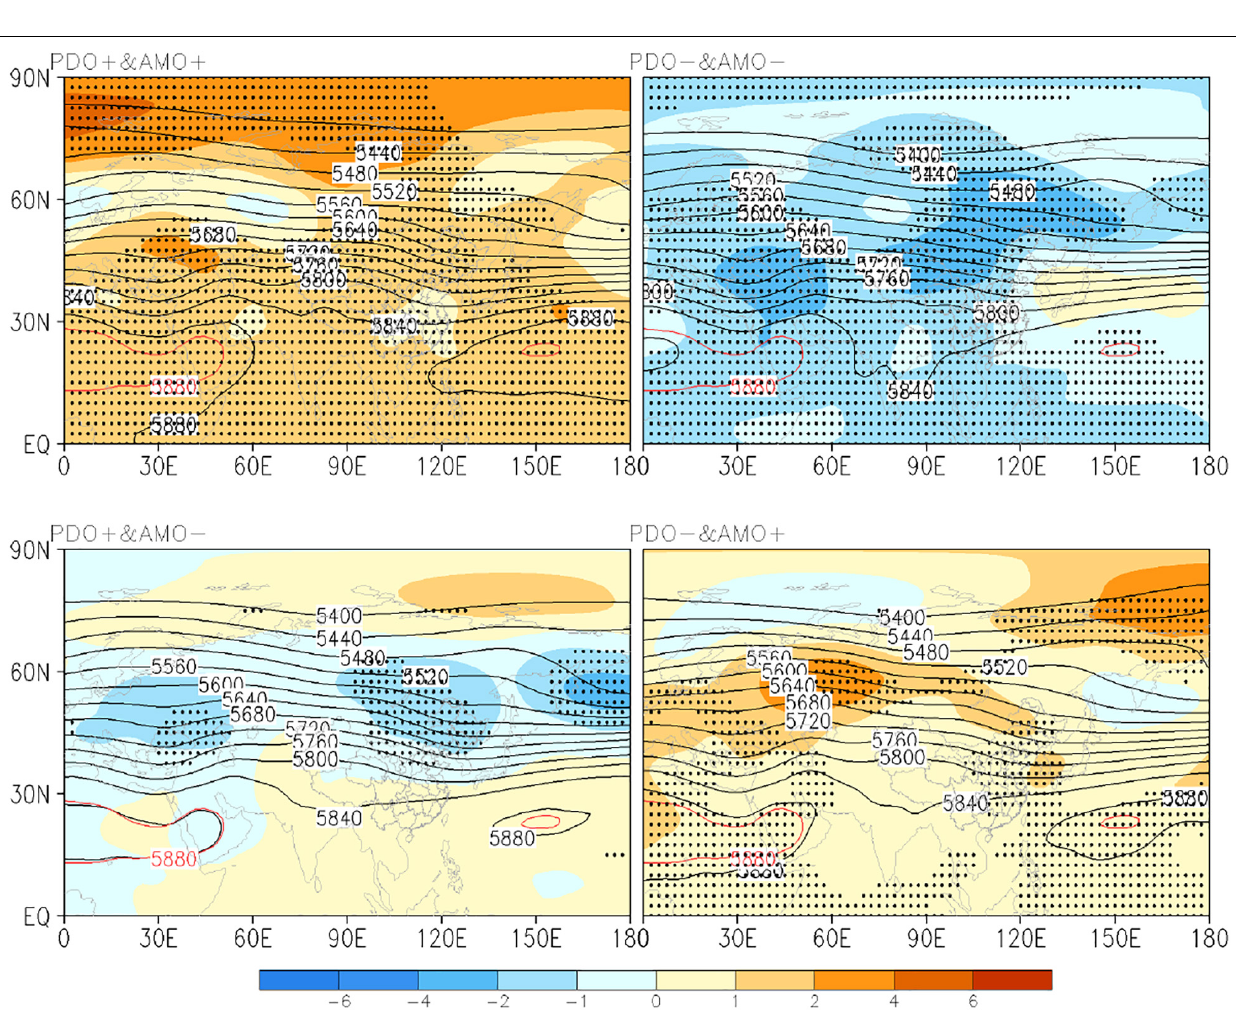
FIGURE 9 | The composite 500 hPa geopotential height in the next years of El Niño events during 1961–2019 under different PDO and AMO phases. The punctate areas pass the significance test at 90% confidence level.The red lines denote 588 dagpm of climatology and shaded area denotes 500 hPa anomalies (the same